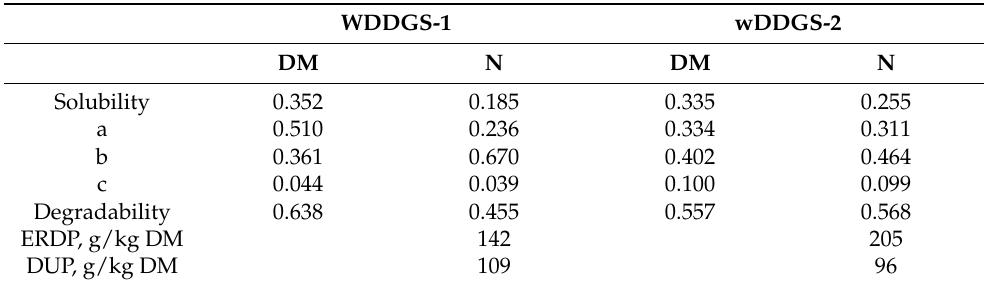
Table A4. Rumen dry matter (DM) and nitrogen (N) degradability parameters of wDDGS-1 and